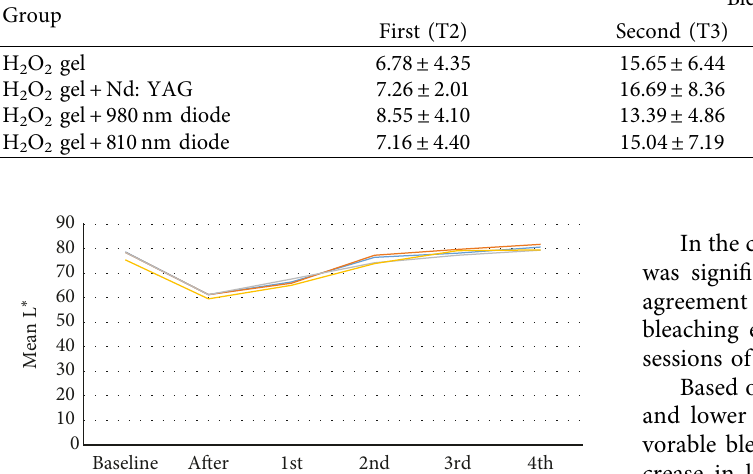
Table 1: Mean whitening values and standard deviations for each group at each bleaching session. Group